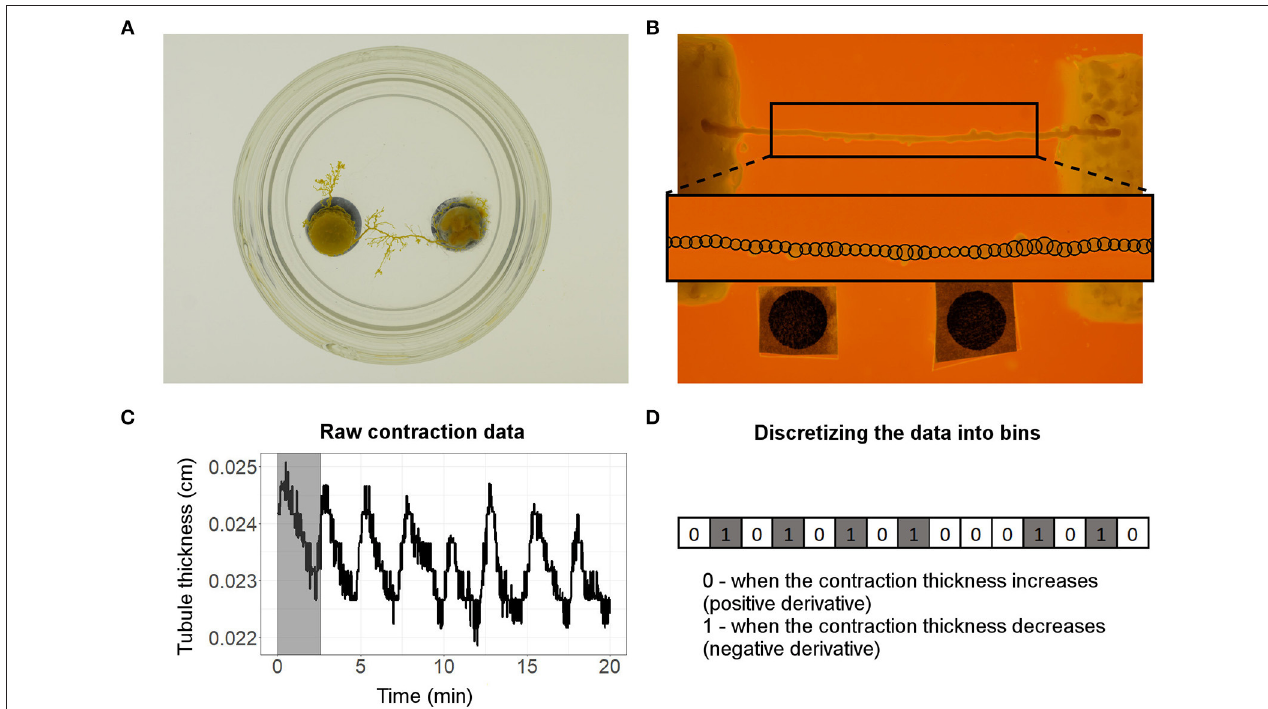
FIGURE 1 | (A) Picture of the setup used to make the tubule-shaped cells of P. polycephalum . (B) Straightened tubule of P. polycephalum placed between 2 food sources (10% w/v oat-agar block on the left and 2% w/v oat-agar block on the right). The two black discs (Ø = 0.3cm) at the bottom of the image were used as reference points and scale for the image analysis. Outset shows the 50 equidistant locations along the length of the tubule (shown by black circles along the tubule axis) at which the contractions were measured. (C) An example of a contractile behavior observed at the 25th contractile location on the tubule. The period of the first oscillation of the contractile behavior (shown by the shaded region) was found to be 2.58min. (D) Discretized version of the raw data used in calculating the transfer entropy. A value of 0 or 1 is assigned when the contractions increase or decrease, respectively, in time. The derivatives shown are for the first 15 time steps of the raw data shown in (C) .